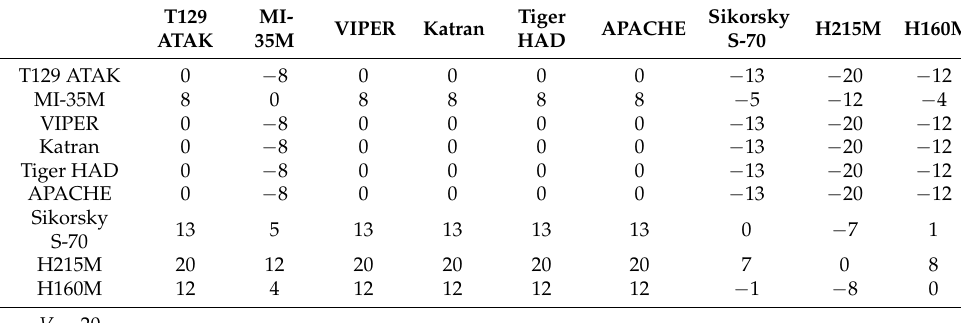
Table 15. Intra-criterion analysis regarding the criterion Troop